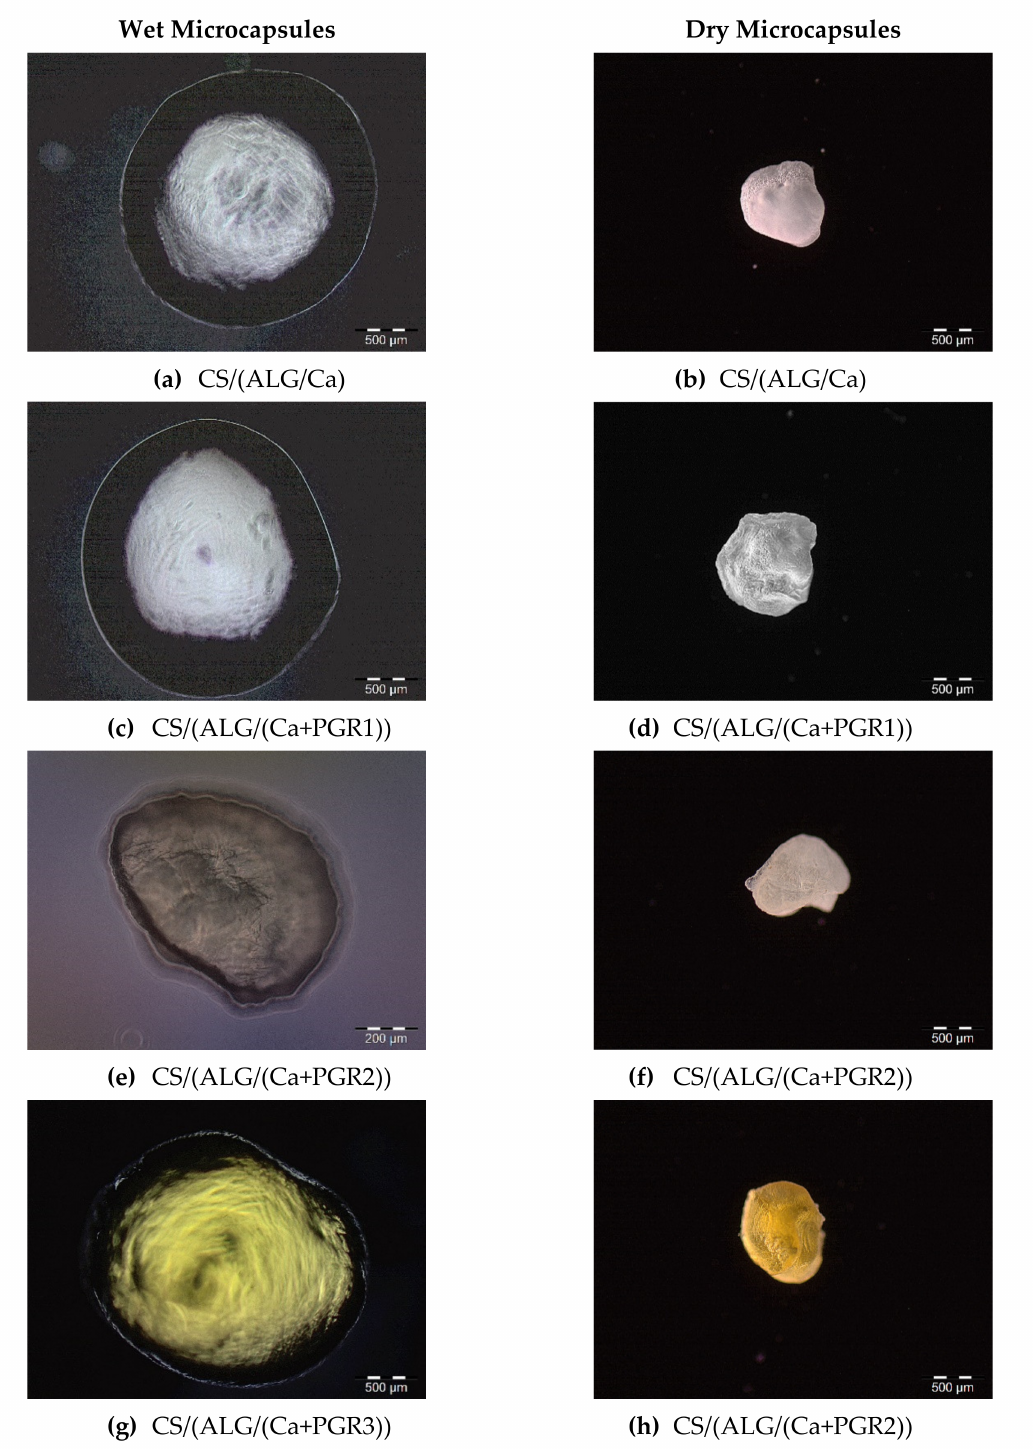
Figure 2. Optical microscope microphotographs of wet (left) and dry (right) microcapsules as denoted. Microcapsule was prepared without ( a , b ) and with PGR1 ( c , d ), PGR2 ( e , f ) and PGR3 ( g , h ). Bars are indicated. SEM microphotographs of dried microcapsules are shown in Figure 3. The size of dry microcapsules observed by SEM follows values obtained by optical microscopy